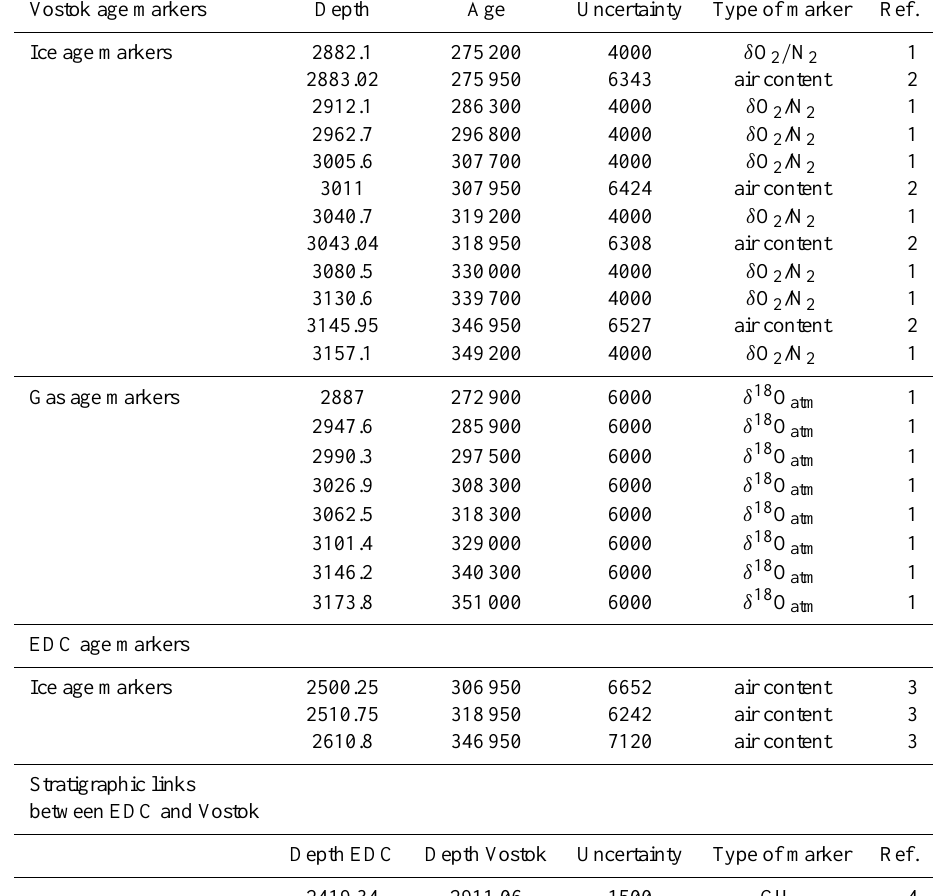
Table 2. List of markers used to constrain EDC and Vostok ice cores between 269 and 355ka for the AICC2012 chronology. References (“Ref.”): (1) Suwa and Bender (2008), (2) Lipenkov et al. (2011), (3) Raynaud et al. (2007) and (4) Bazin et al.